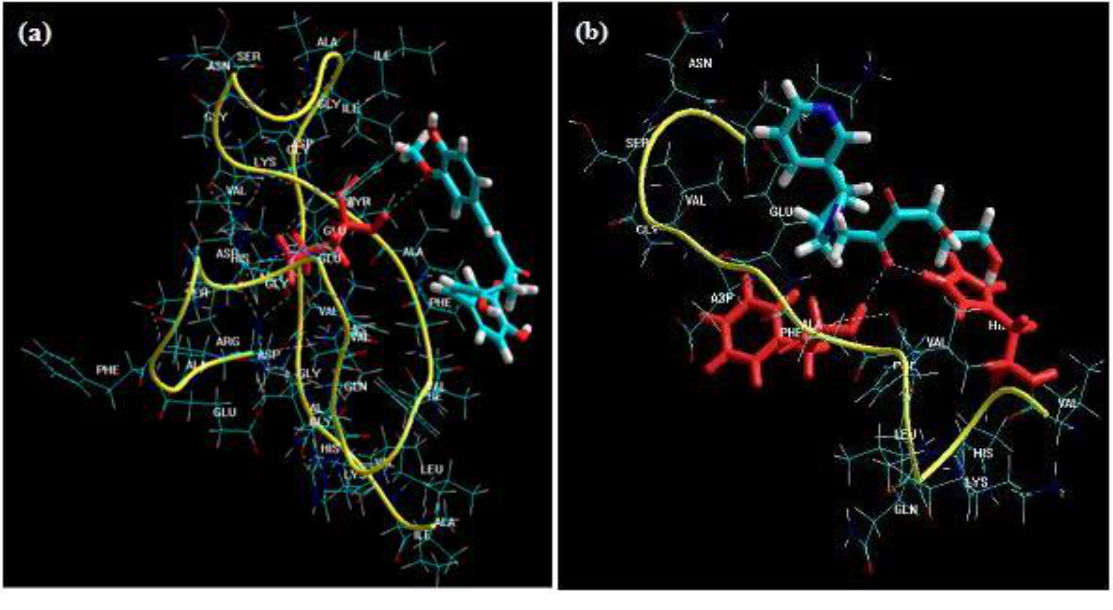
]; and 25 & Aβ ] with Aβ protein. 13 20